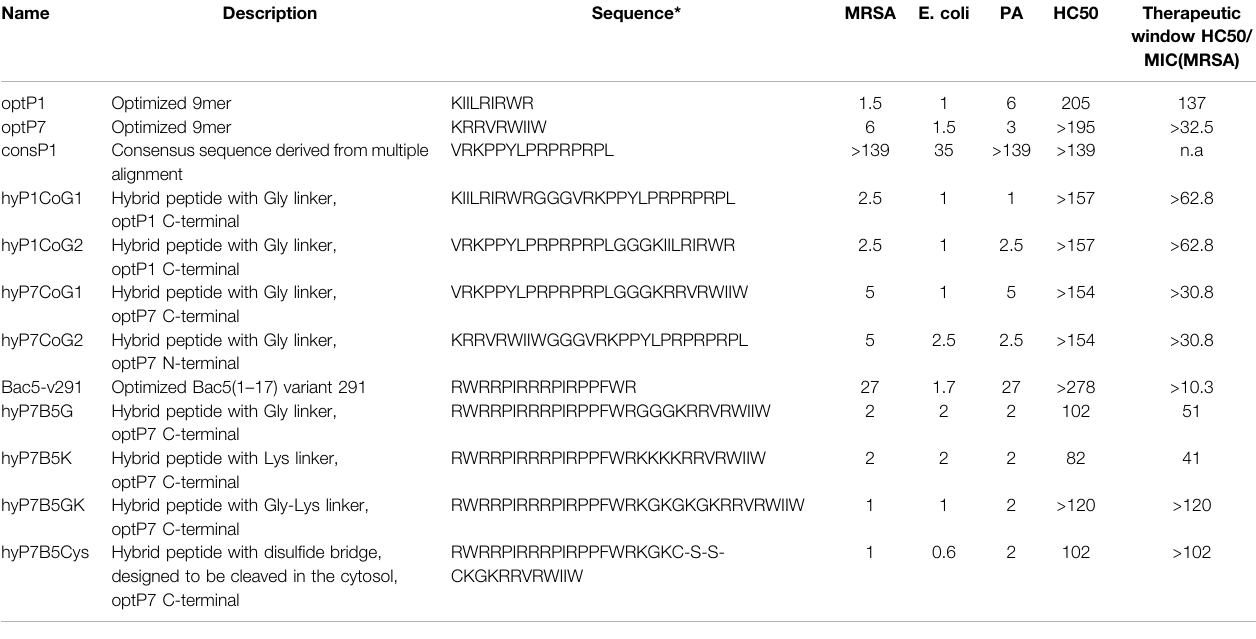
TABLE 1 | Minimum inhibitory concentrations (MIC) in µM. Data are for n (cid:2) 3 with modal values reported; all values determined in Mueller-Hinton broth (MHb) using 5 × 10 5 CFU/mlbacteria;MRSA (cid:2) methicillin-resistant Staphylococcusaureus ,HC50representsthepeptideconcentrationneededtoinducehaemolysisinhumanredblood cells at 50%. * means that all peptides are C-terminal amidated. PA stands for P. aeruginosa , n.a. for not applicable. The therapeutic window is given for MRSA only, as an example for their potential as a drug development candidate.